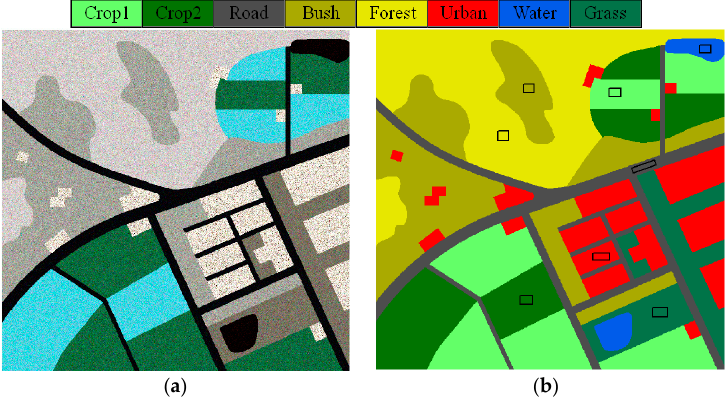
Figure 4. Simulated PolSAR image as the first dataset used in the experiment: ( a ) Pauli color-coded image and ( b ) the manual classification map of the simulated image. Boxes in ( b ) are the areas of the training samples for the simulated image.